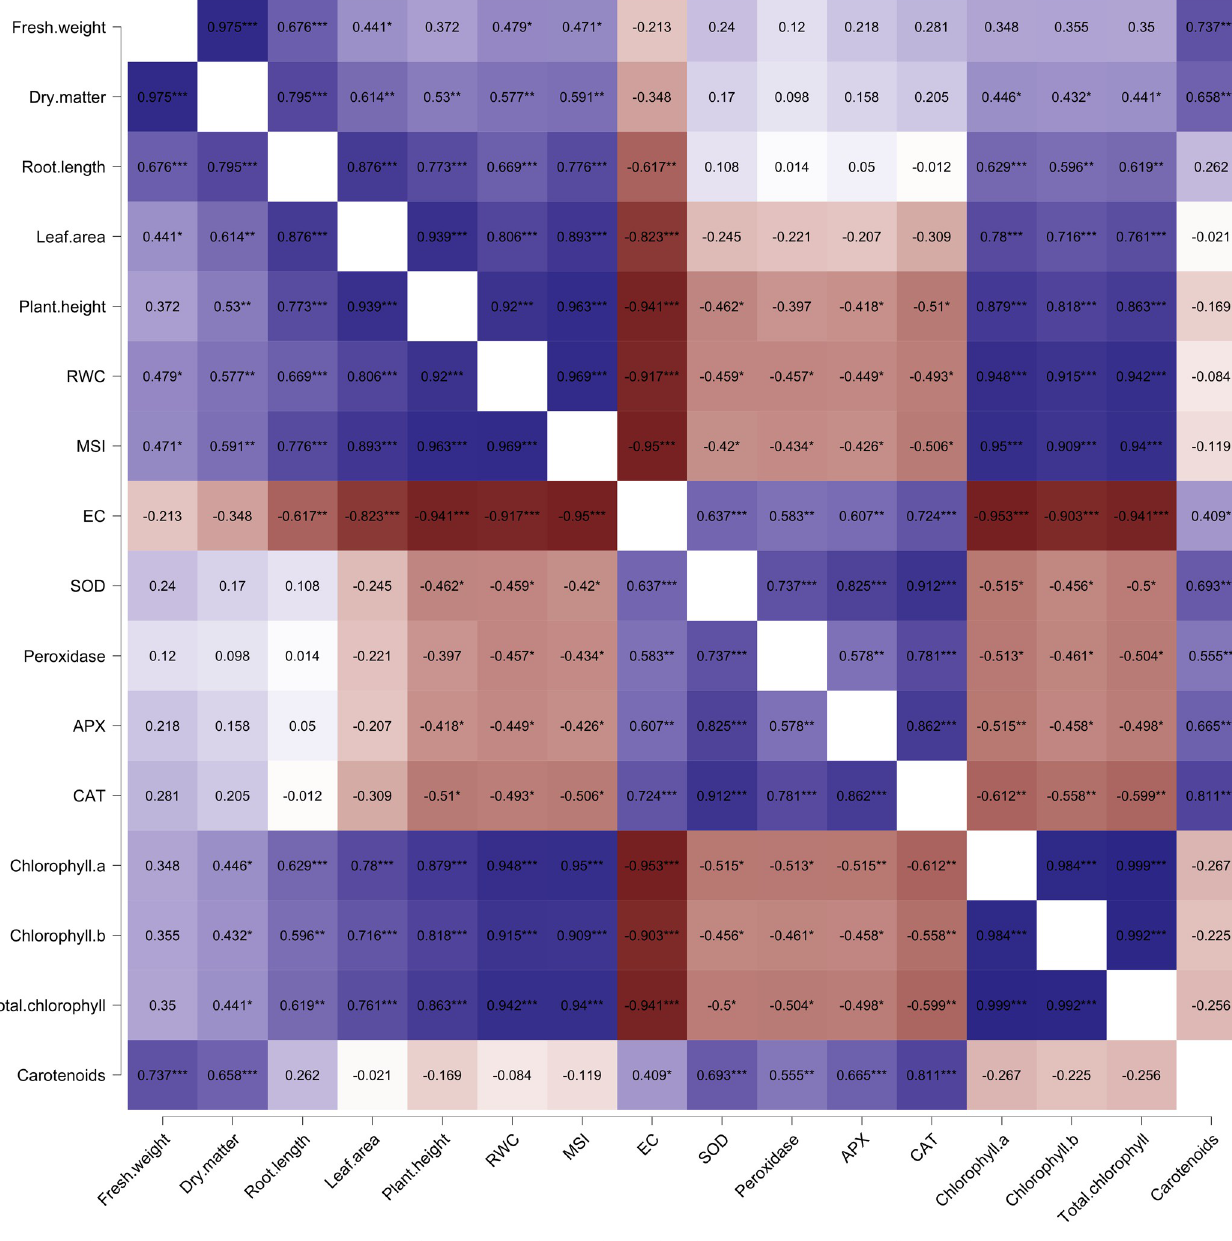
Fig 1. Correlations among the sixteen traits studied for B . juncea plants cultivated under water stress in the influence of silicon and mycorrhizal inoculation. weight (0.418), peroxidase (0.56), ascorbate (0.697), catalase (0.836), and carotenoid (0.599) (Fig 1). However, the peroxidase concentration showed a significant correlation only with catalase (0.619), in addition to superoxidase dismutase. In case of ascorbate concentration, it was observed that there were considerable positive correlations with catalase (0.752) and caroten- oid (0.557). At the same time, catalase concentration was also correlated with fresh weight (0.519) and carotenoid content (0.796), besides other traits mentioned above (Fig 1). Finally,